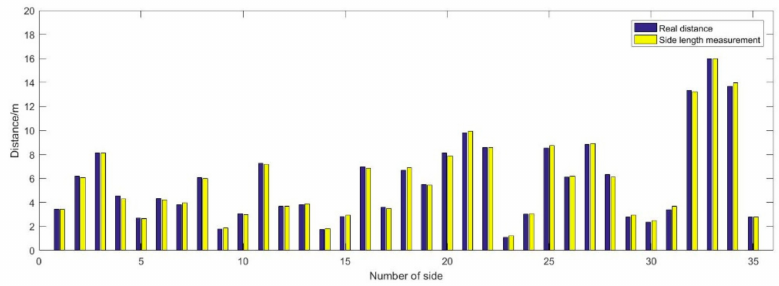
Figure 9. Comparison between mean distance measured by UWB and Real distance.